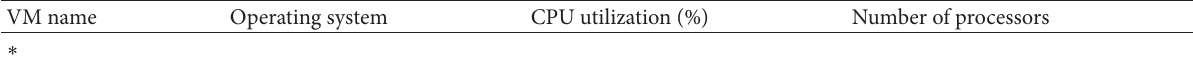
Table 16: Local list of node 2 (S2).